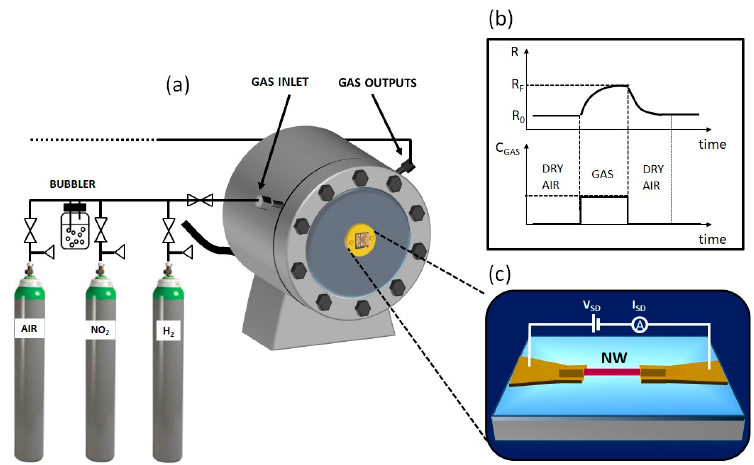
Figure 3. Schematic representation of the measurement setup used for sensing tests. ( a ) The setup consists of a 1000 cm 3 stainless steel-test chamber, connected to a gas line fed from certified gas bottles, mixed through mass flow meters. A bubbler is connected to the line for obtaining humidity and ethanol air mixtures; ( b ) sketch of the transduced signal, i.e., the nanowire (NW) resistance variations as a function of time, related to the gas concentration inside the chamber during a test cycle; ( c ) scheme of the devices under test, showing the electric circuit for gas detection.